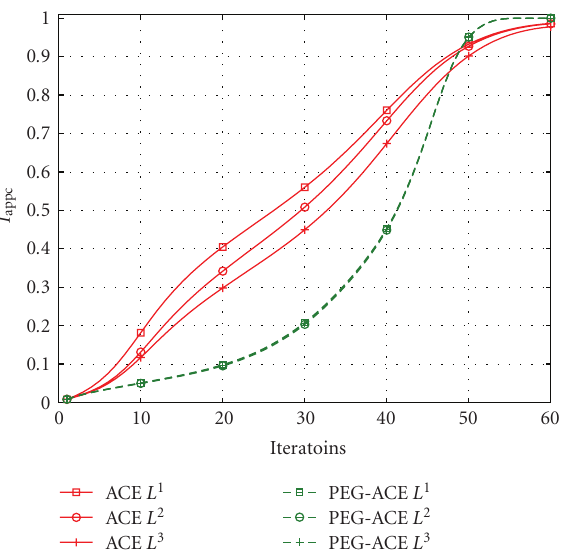
Figure 7: Check node a posteriori MI as a function of the number of decoder iterations at E b /N 0 = 0 . 7 dB.